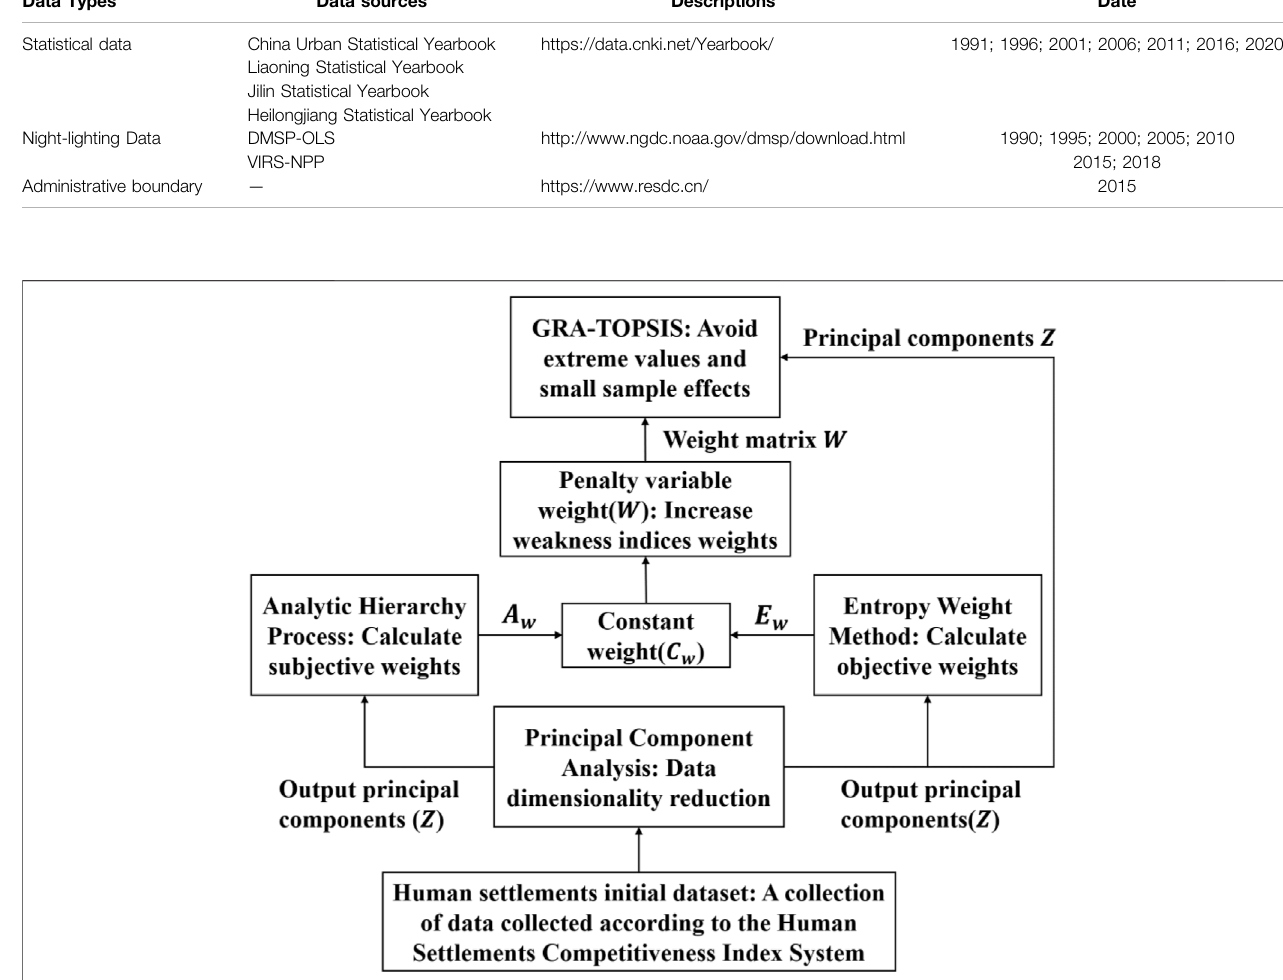
FIGURE 2 | HSC evaluation process.